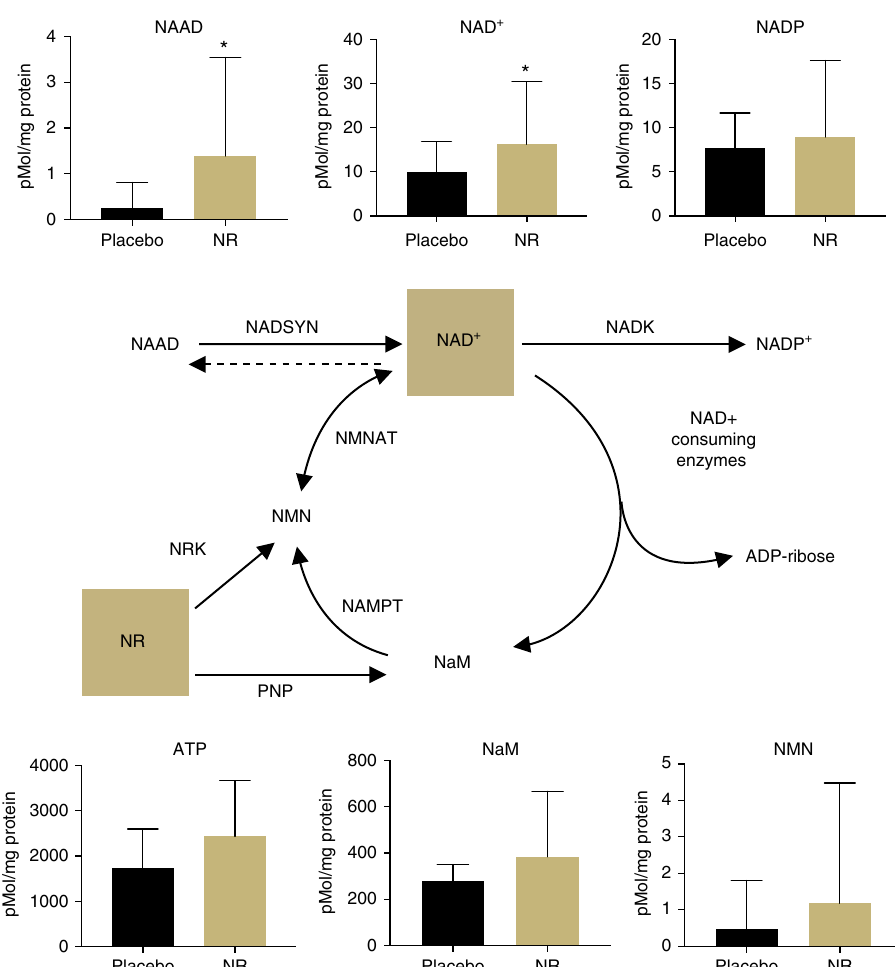
Fig. 2 NAD + metabolome. NAD + and related metabolite concentrations in peripheral blood mononuclear cells increased after oral placebo vs. NR supplementation normalized to total protein content. Data are mean ± SD. * indicates unadjusted P < 0.05 by one-tailed paired t- test. N = 21 (Group A = 11; Group B =